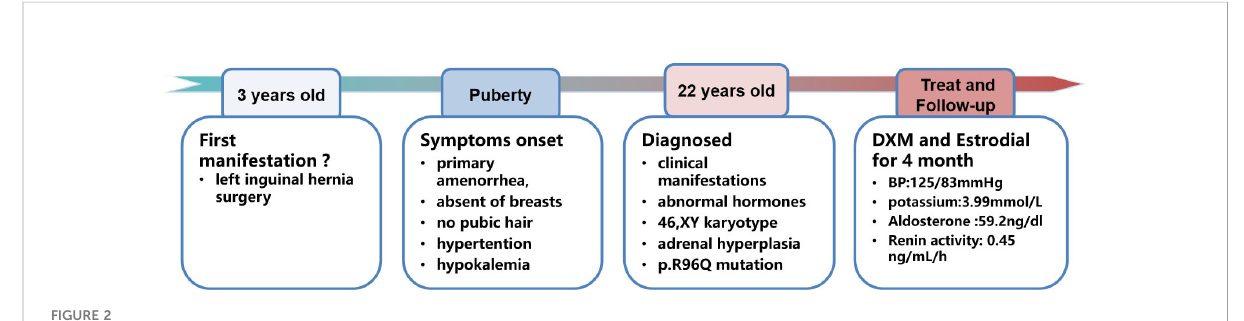
FIGURE 2 Timeline of the disease